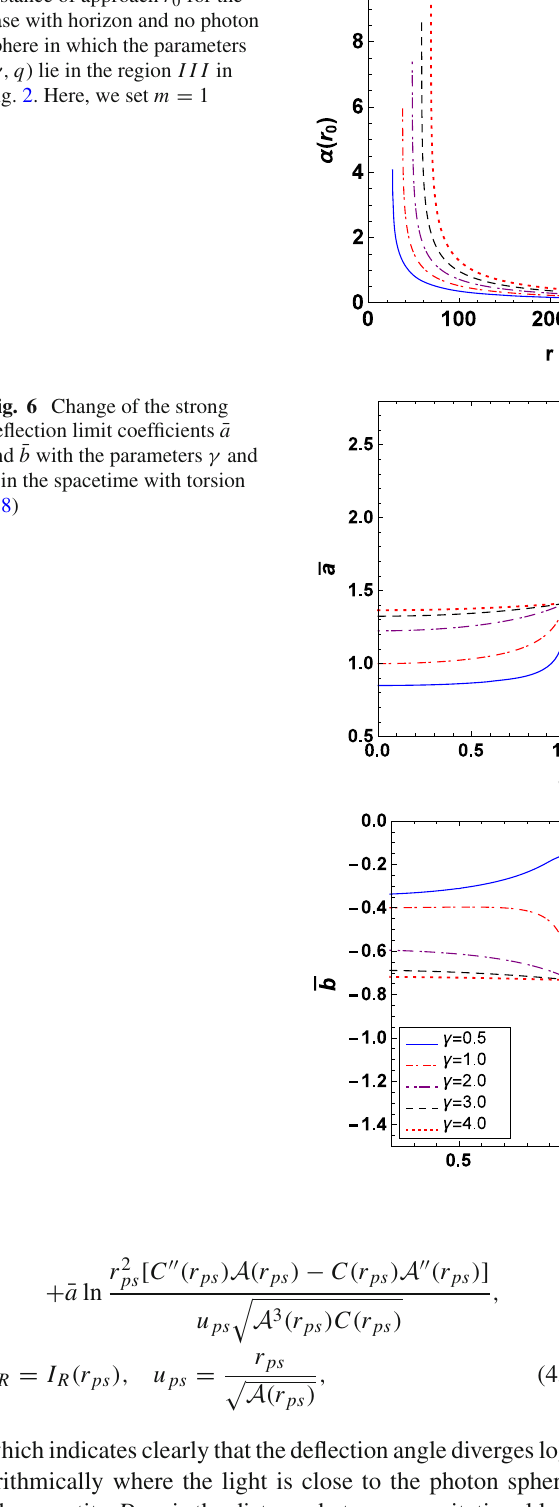
Fig. 5 Deflection angle α( r 0 ) as a function of the closest distance of approach r 0 for the case with horizon and no photon sphere in which the parameters ( γ, q ) lie in the region I I I in